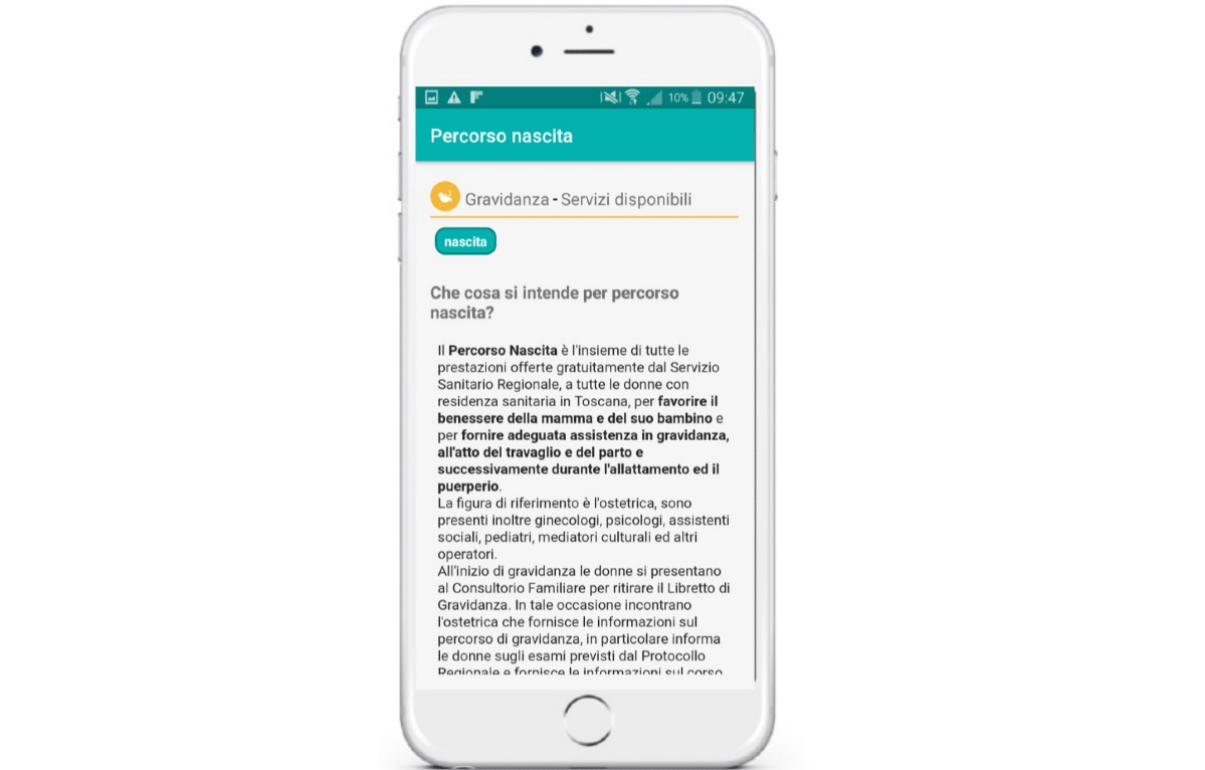
Figure 4. hAPPyMamma information repository: provision of professionally validated information (in a frequently asked questions format) on health promotion, prevention, and health care services concerning pregnancy, childbirth, and the postpartum period, with information proactively suggested via pop-up messages.